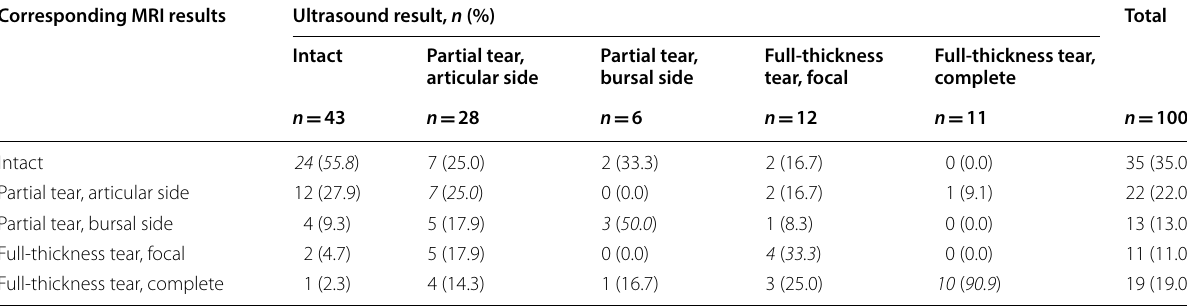
Italicized values highlight agreement